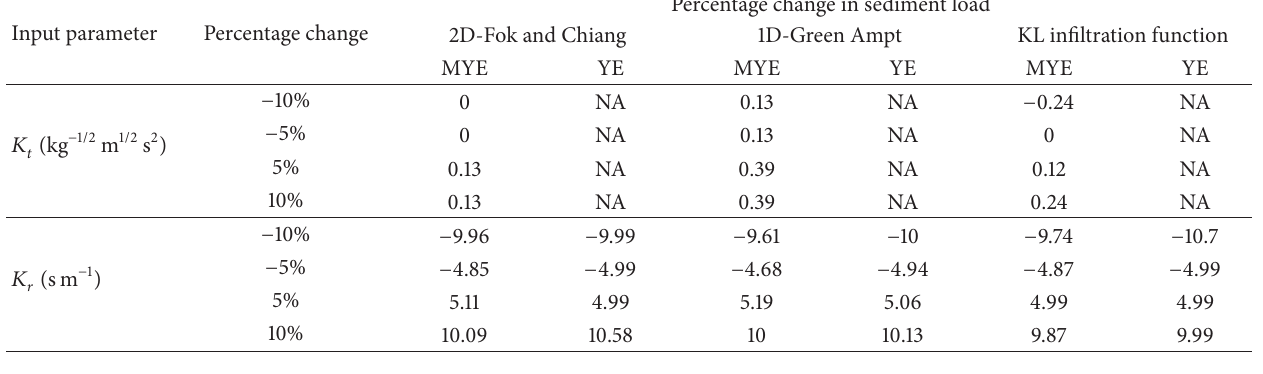
Table 4: Sensitivity analysis of erosion module parameters.